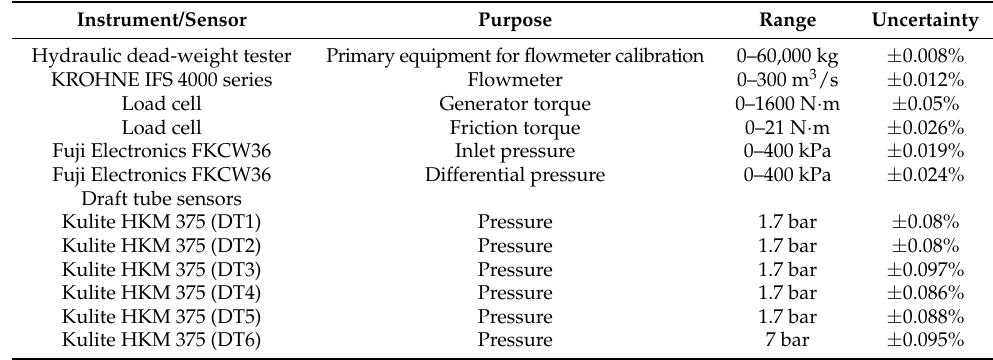
Table 1. Details of the instrumentation used in the experiments.